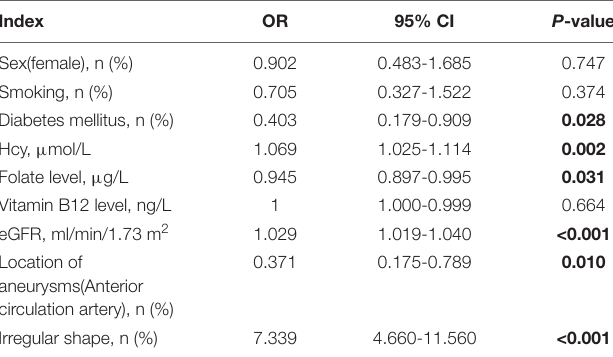
TABLE 2 | Multivariate logistic regression analysis between patients with UIAs and those with RIAs.